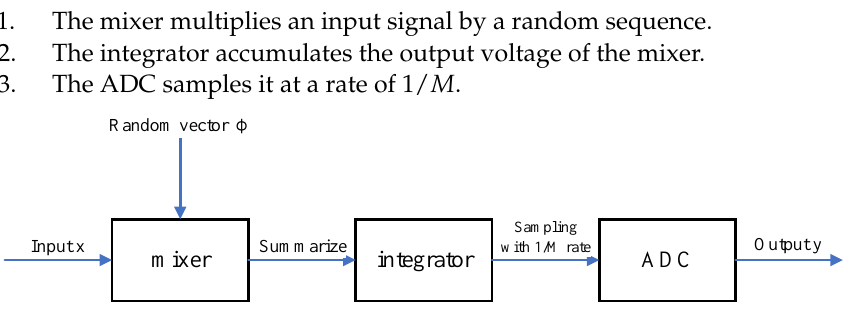
Figure 1. A classical random demodulator (RD) architecture in an analog compressed sensing application.